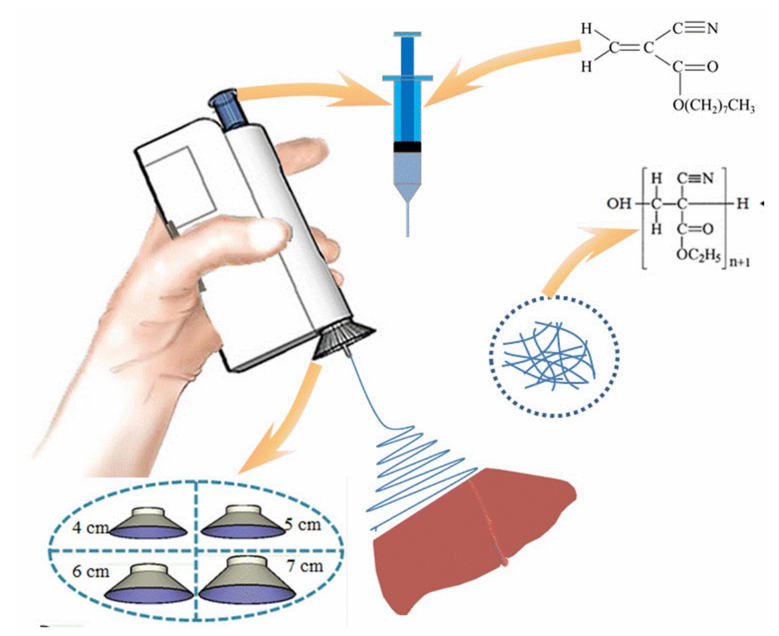
Figure 12. Schematic diagram of the electric field-modified e-spinning NOCA fibers for liver resec- tion